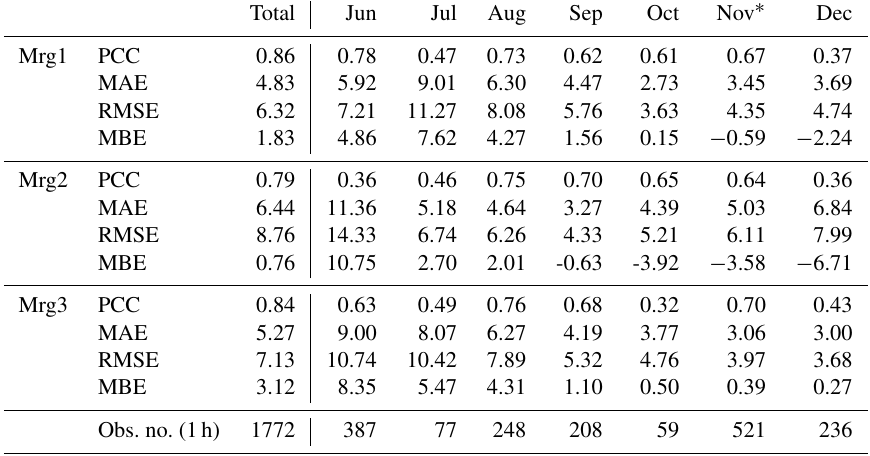
Table 4. Intercorrelation and bias between the LCSs calibrated in the laboratory and the reference. Statistical metrics considered are the Pearson correlation coefficient (PCC), mean absolute error (MAE), root mean square error (RMSE) and mean bias error (MBE). For each statistical metric, its total, monthly values and the number of hourly observations that are used to perform the calculation are reported. The sum of the hourly observations in the monthly analysis differs from the total of 1793 observations by the data from 31 May to 14 June. Total